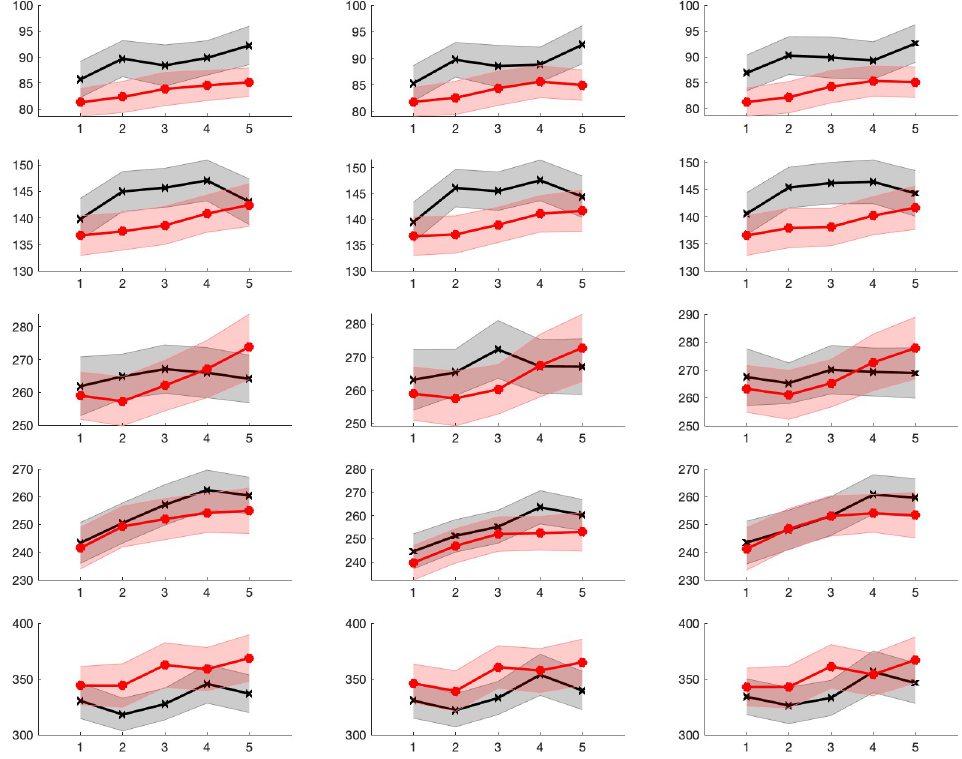
Fig 6. Means and shaded 95% confidence intervals for local peaks (left column), 50% fractional area latency (middle column) and 50% jackknife fractional area latency (right column) for the 5 time on task segments. Data are superposed for younger (black) and older (red) participants. Note that the time courses both of within-subject as well as of between-subject effects are highly comparable between